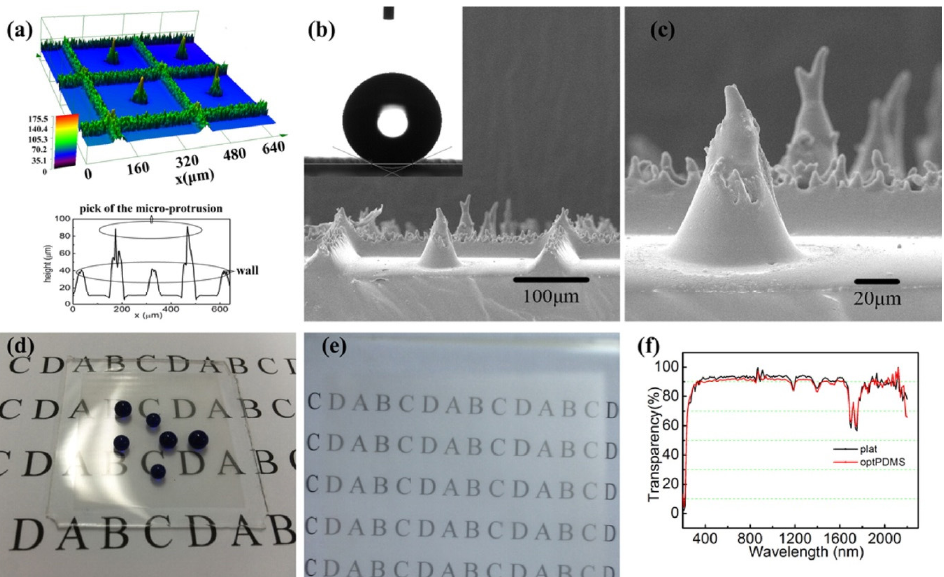
Figure 12. Surface microstructure of PDMS as a result of molding into a stainless steel substrate ( a ) laser microscope and SEM ( b ) 500× and ( c ) 2000×. The SCA of this optimal surface is 154.5° ± 1.7° and SA 6° ± 0.5°; ( d ) Sample of optimally designed PDMS coated on the paper; and ( e ) it was held up to keep a certain distance (10 cm) from the paper; ( f ) Transparency of the optimal designed surface is over 91% in the visible light wavelength [38].